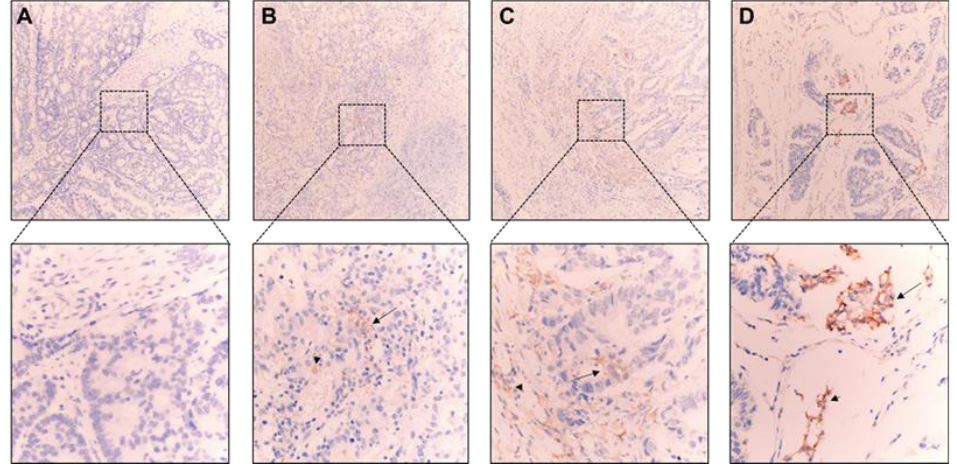
Figure 1. Representative images of PD-L1 staining in CRC tumor cells (arrow head) and immune cells (arrow). CRCs with CPS of <1 ( A ), 1 – 4 ( B ), 5 – 9 ( C ), and ≥10 ( D ) are shown at 100× and 400× magnification.